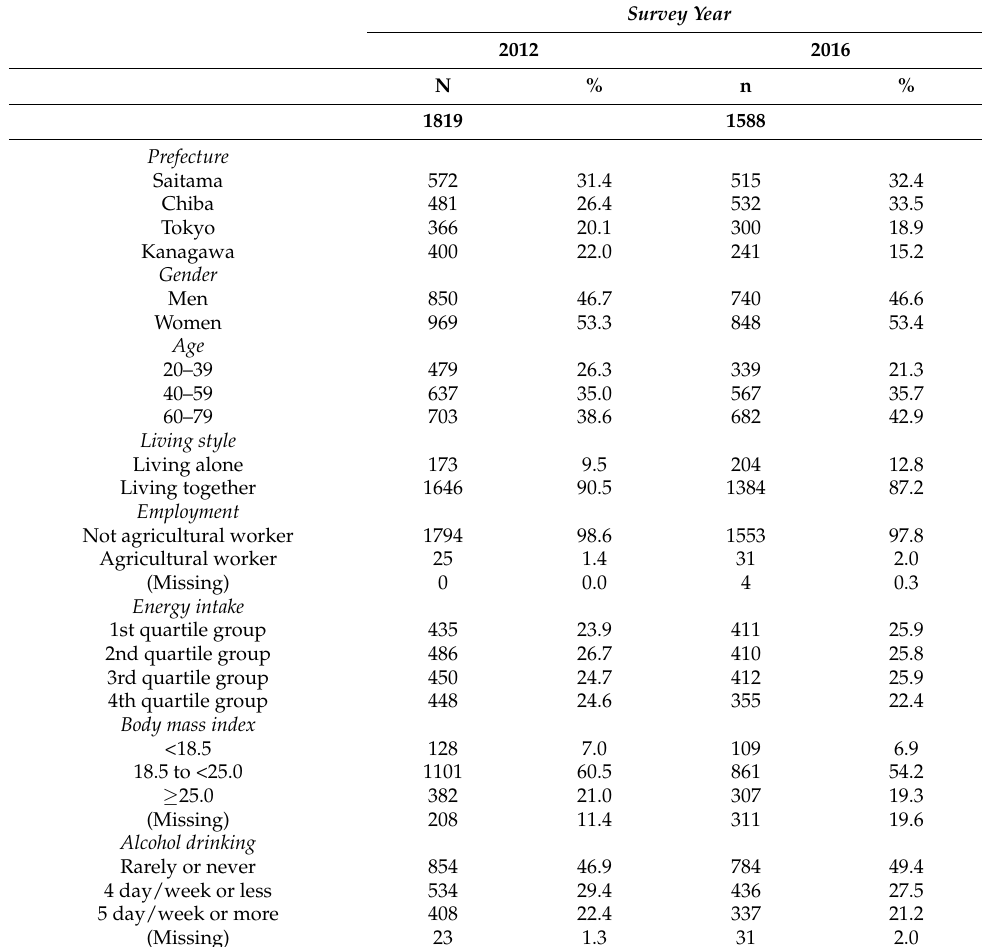
Table A1. Information of subjects among Kanto 1.